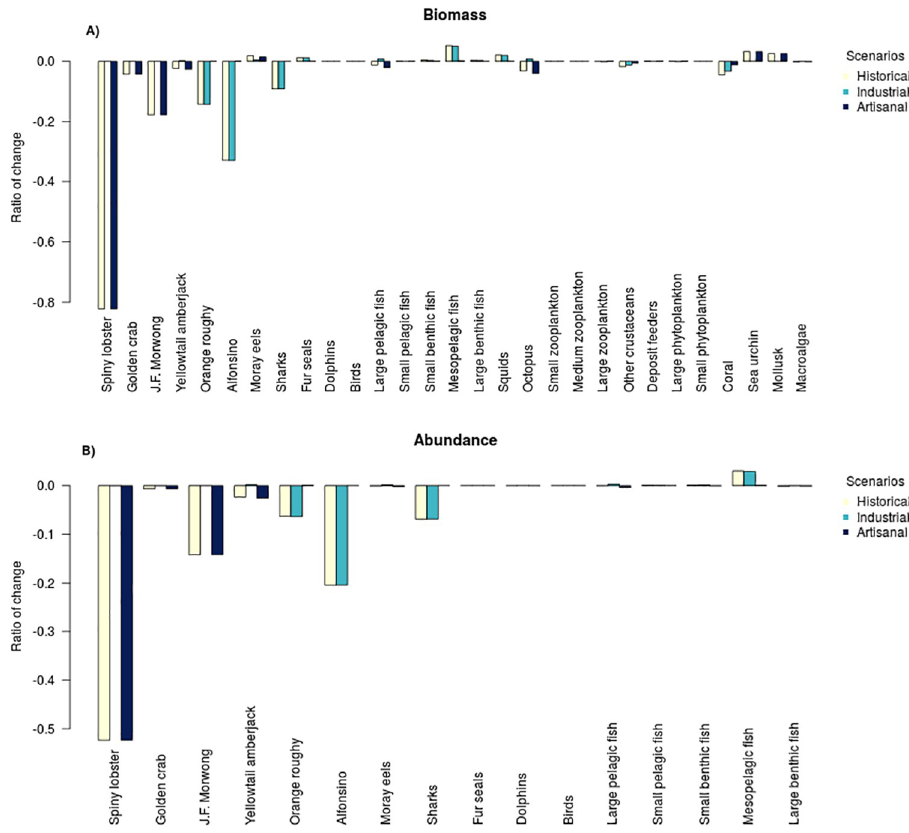
Fig 5. Relative change in biomass (A) and abundance (B) for the scenarios with only artisanal, industrial and the historical fisheries (industrial + artisanal). An unfished ecosystem is the base case for comparisons. Note that the y-axes is the ratio of change against the starting conditions—so a -0.5 result indicates a 50% decrease and a 0.5 result indicates a 50% increase -.